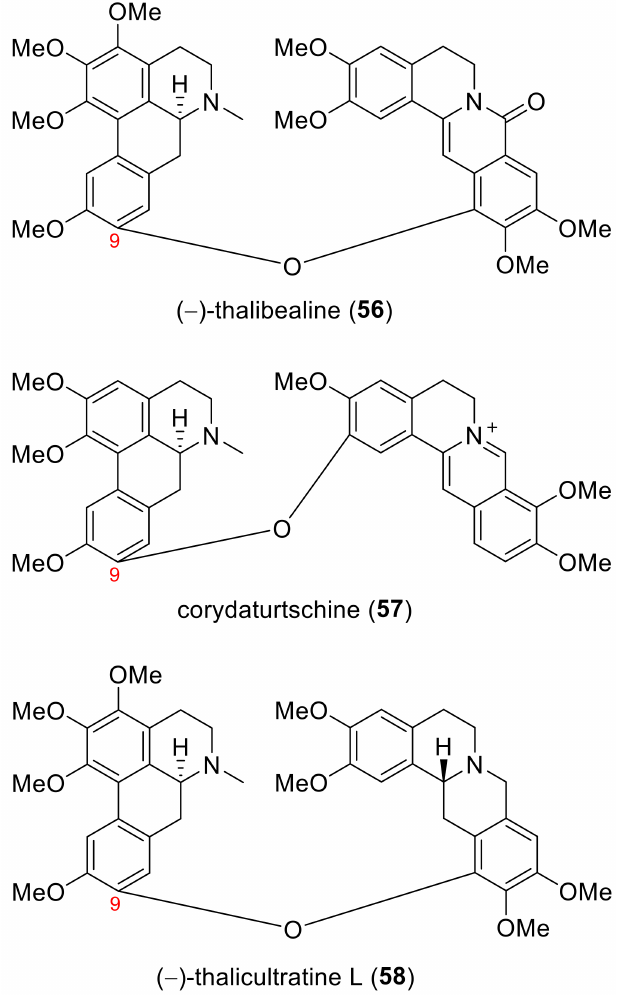
Figure 5. Structures of ( − )-thalibealine ( 56 ), corydaturtschine B ( 57 ), and ( − )-thalicultratine L ( 58 ).